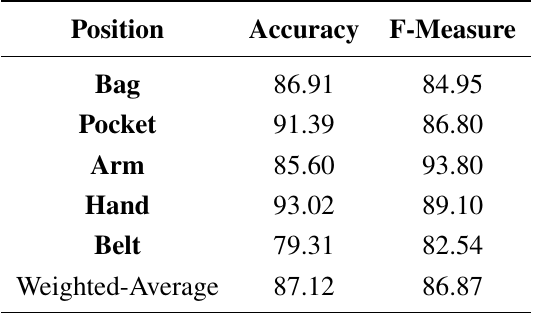
Table 10. Results of the 5-class experiment.